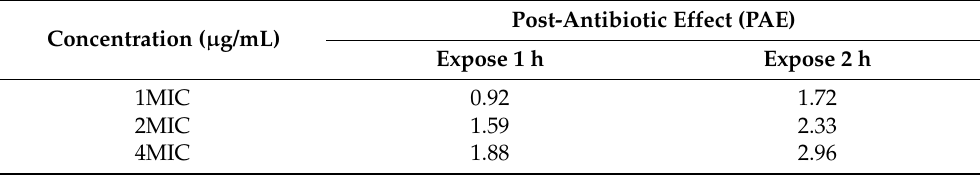
Table 4. The PAE of acetylkitasamycin against S. suis .